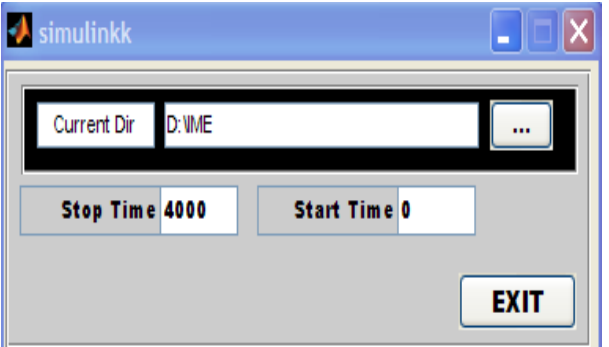
Figura 6. Interfaz de conectividad con el modelo Simulink.